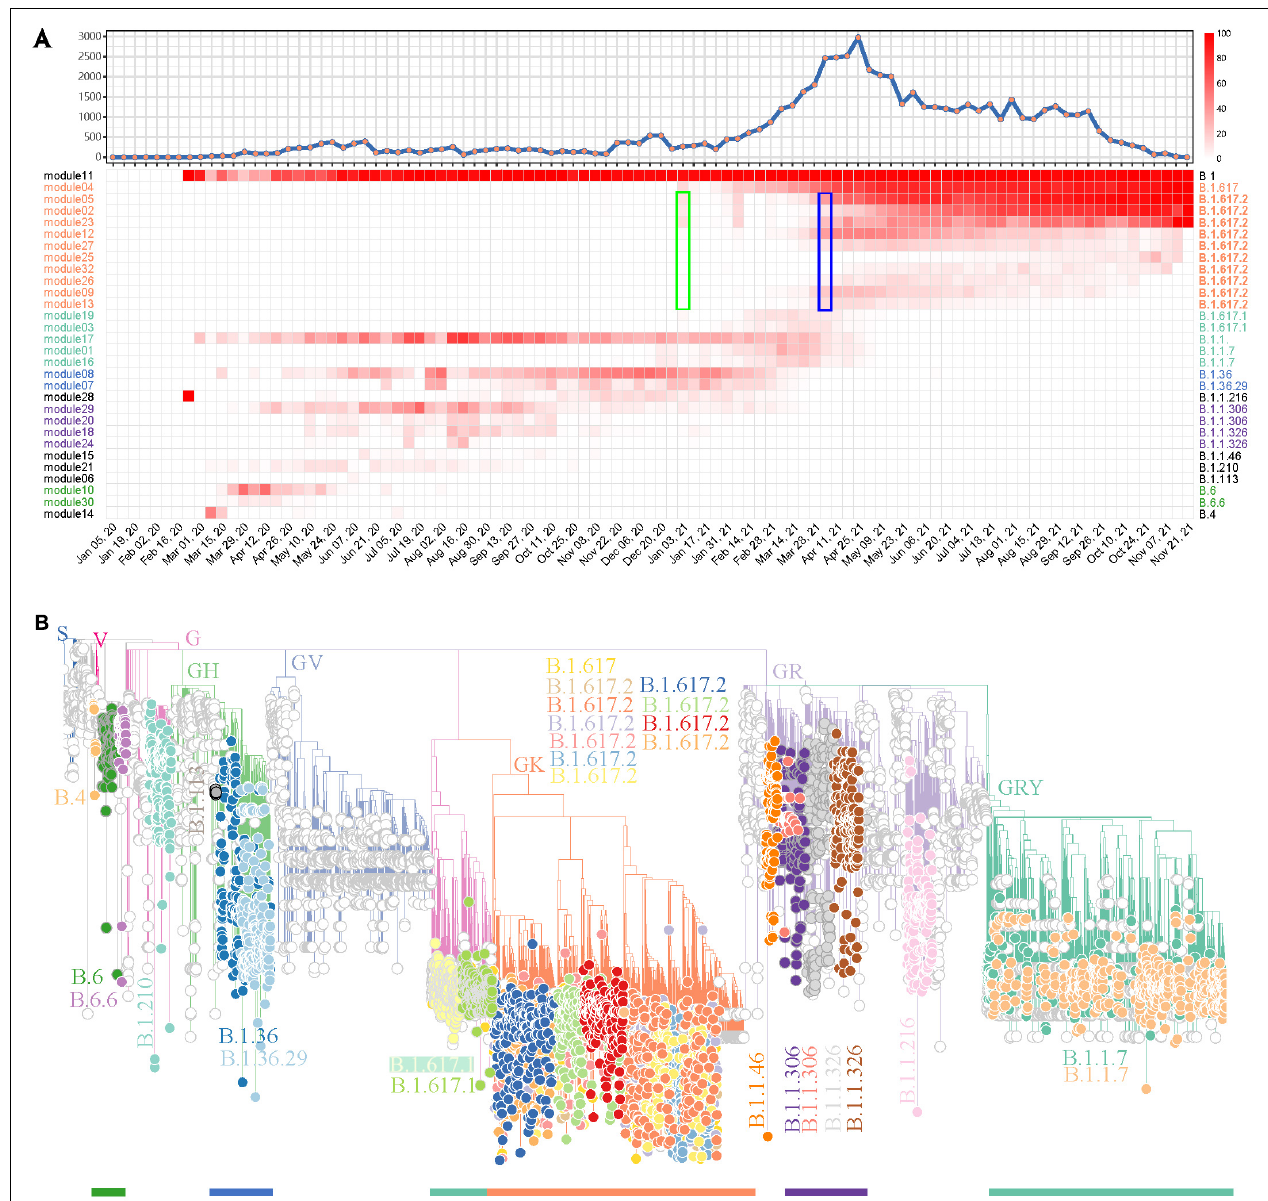
FIGURE 4 | A demonstration to identify SARS-CoV-2 variants prevalent in India using the weighted network. (A) Weekly distribution of SARS-CoV-2 genome sequences according to sampling time (top) and the heatmap of module-based variant prevalence (bottom). Core mutations within each module were used to define the variants. The modules were reordered and colored according to their module clusters and time course. The weeks when Delta (B.1.617.2) was identified as a prevalent variant by network model (green) or reported as a VUI by WHO (blue) are highlighted by rectangles. (B) Phylogenic evaluation of detected endemic SARS-CoV-2 variants in South Africa. The detected variants are highlighted and annotated with visually friendly